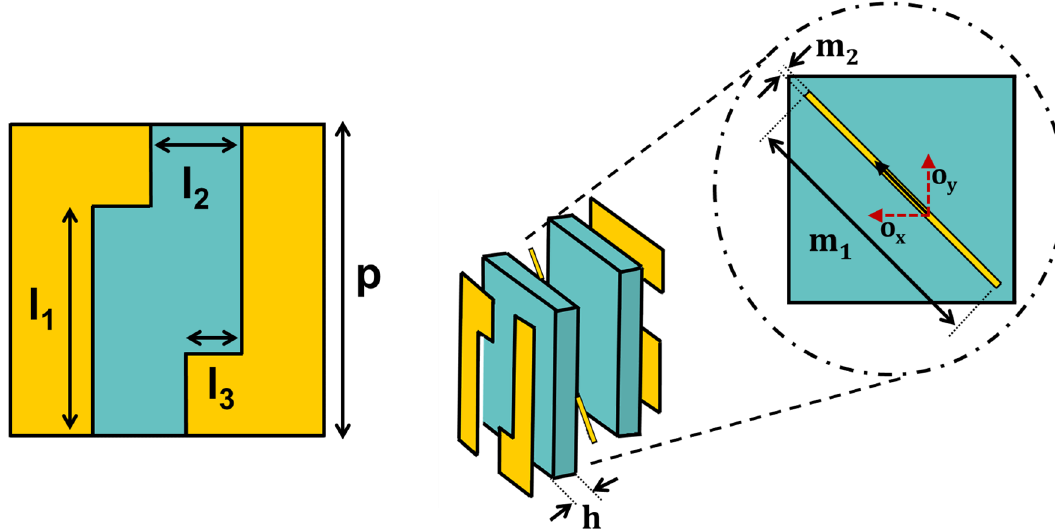
Figure 3. Geometry of the unit cell: p = 8.35 mm, l 1 = 6.15 mm, l 2 = 2.43 mm, l 3 = 1.52 mm, h = 1.16